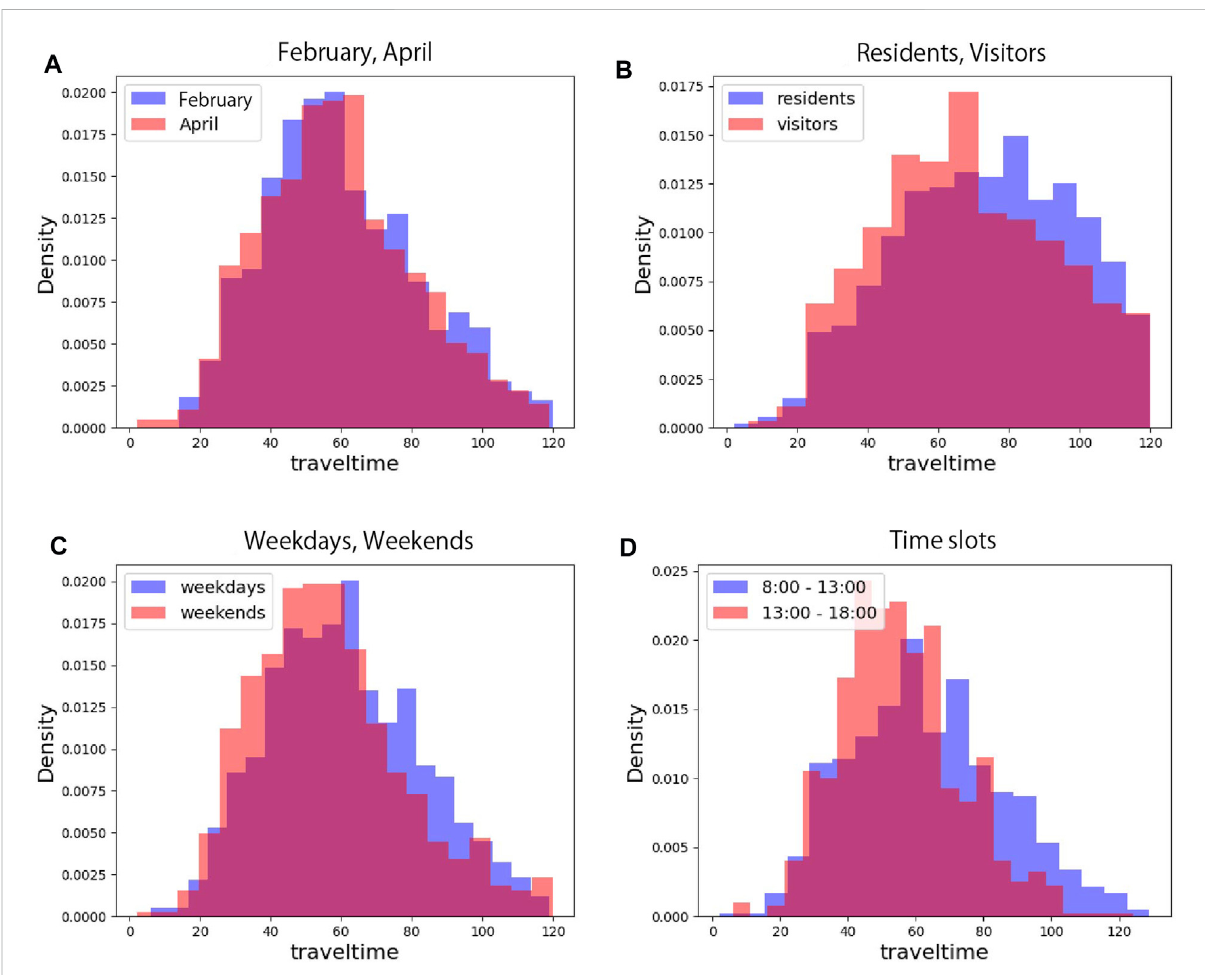
FIGURE 6 Adensityfunctionisformedforthetraveltimebyclassifyingthesetsofoptimalpathsforeachconditionfor travelfromHyakumanbentoKyoto Station. The horizontal axis is the travel time, and the vertical axis is the density. In (A) , the density function is formed for the February and April data. The density function is formed for Kyoto citizens and visitors in (B) , for weekdays and weekends in (C) , and for a departure time of 8:00 to 13:00 and 13:00 to 18:00 in (D) . Note that because the data are from GPS, the travel time includes not only the effect of traf fi c congestion but also the lag between the start/end times of the trip, the time of the measurement, and the waiting